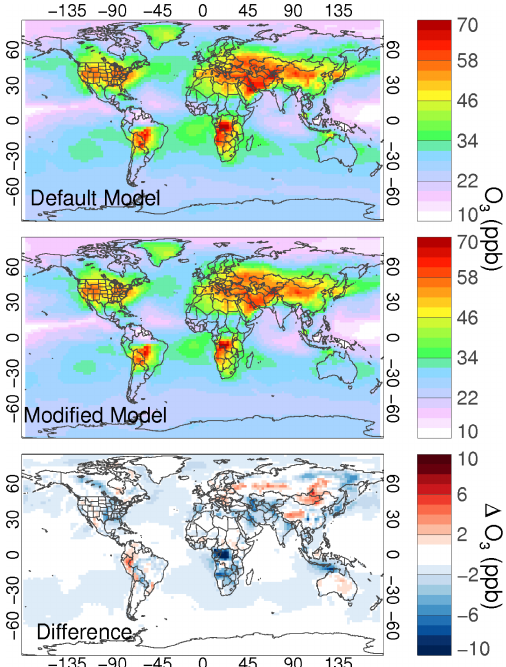
Figure 1. Simulated global surface O 3 concentrations for August 2010 in the (top) default, and (middle) modified GEOS-Chem con- figuration. (Bottom) Difference between the modified and default